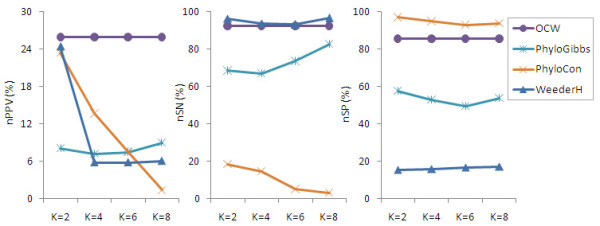
Performance of OCW, PhyloCon, PhyloGibbs and WeederH on noisy data. The extent of noise was adjusted by introducing an increasing number (k) of random promoters into the phylogenetic sets.